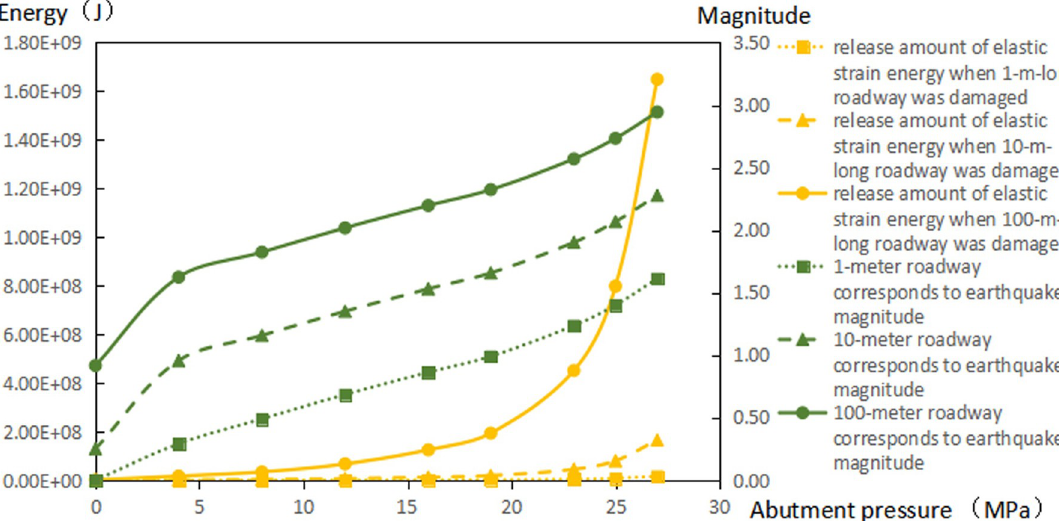
Fig 11. The increments of released elastic strain energy and corresponding magnitudes on conditions of different failure lengths of the roadway before increasing the vertical stress by 1 MPa.